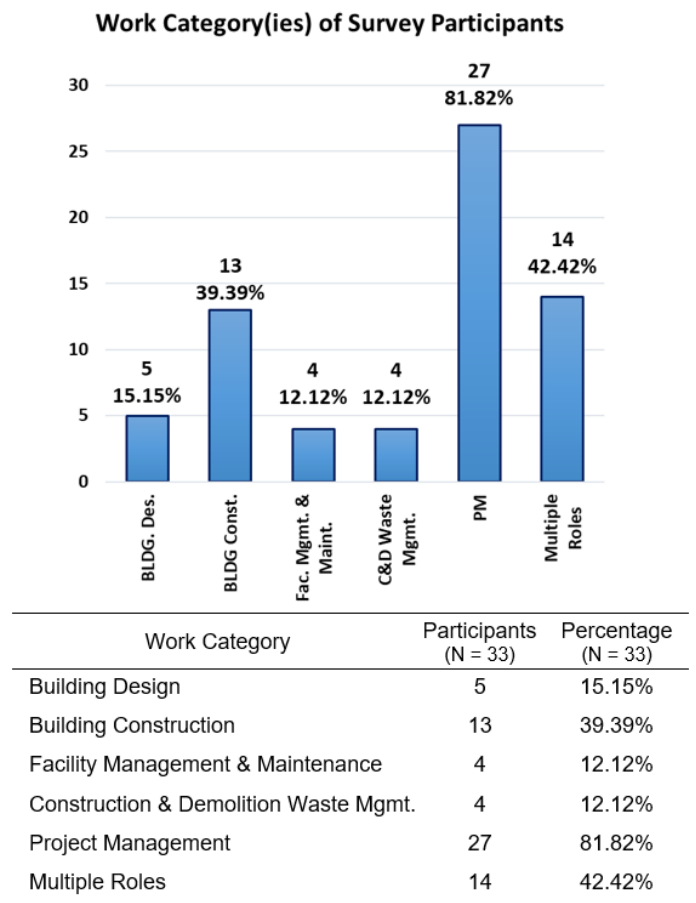
Figure 4. Work Category(ies) and project role(s) of survey participants.